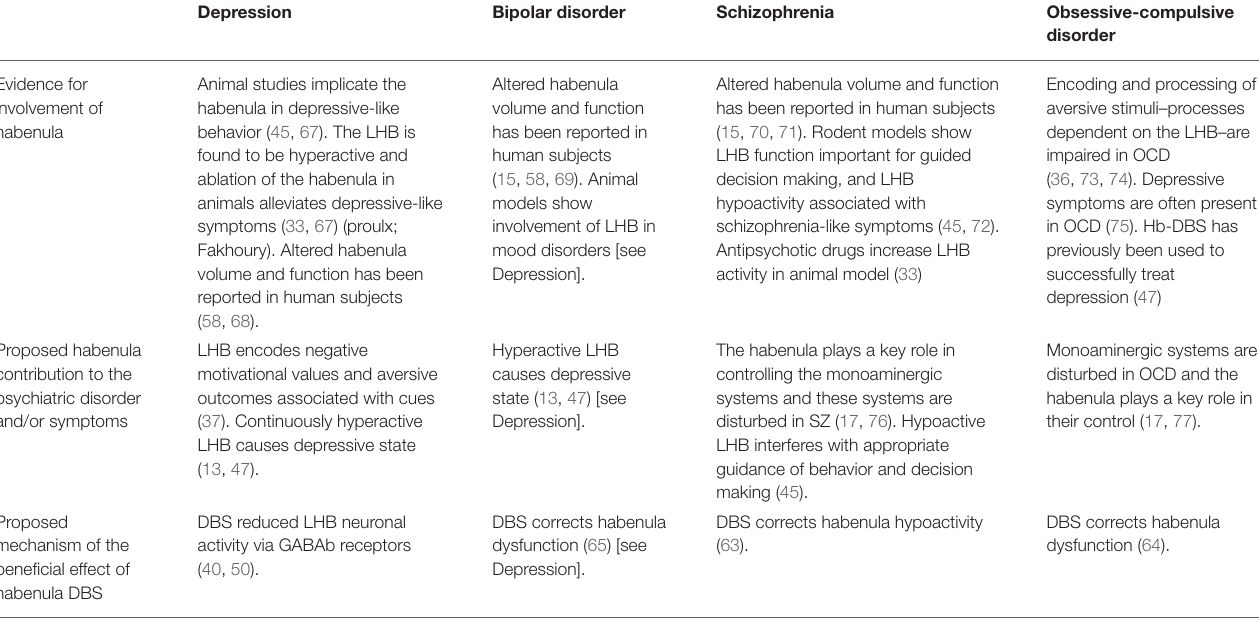
TABLE 3 | Rationale for Habenula involvement in psychiatric